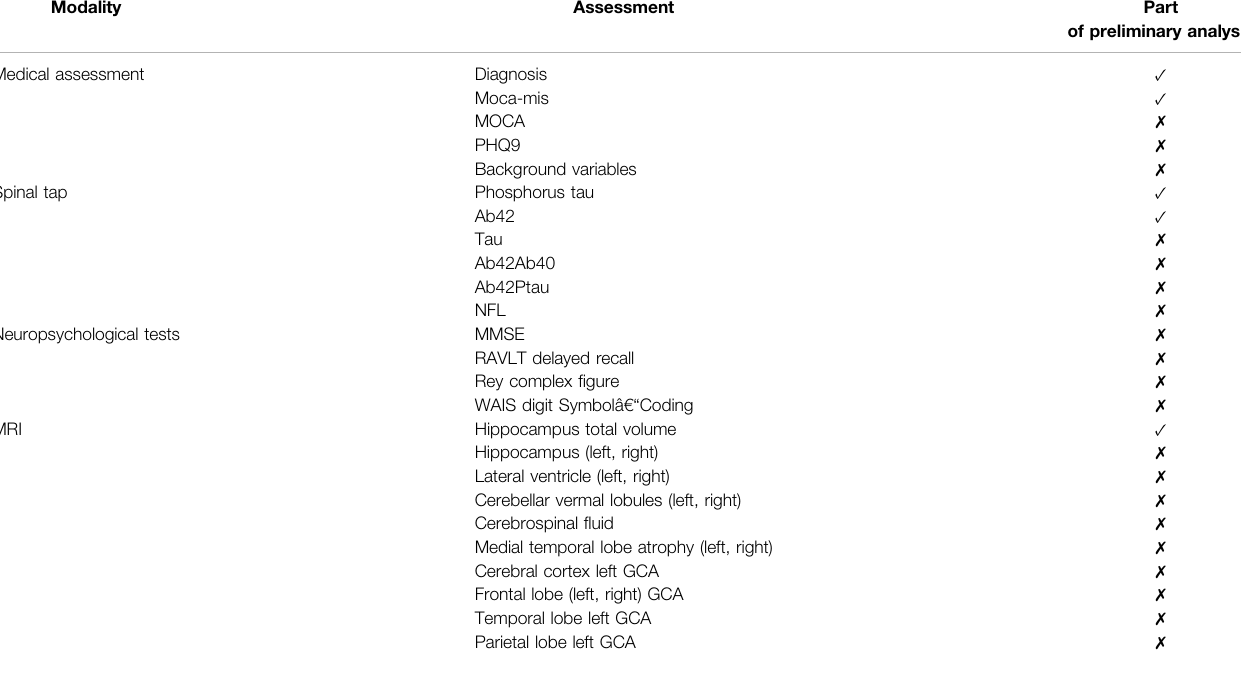
TABLE4| Summarytableofclinicalassessmentmetricsavailable,andanindicationofwhichonesareusedinthecorrelationanalysis.FromtheMRIwehaverelativevolume measurements for 248 brain regions; the table lists regions whose absolute Pearson correlation with diagnosis exceeds 0.7. Modality